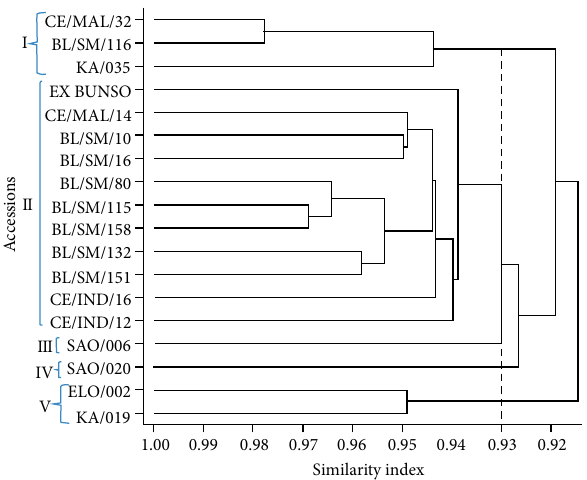
Figure 1: Cluster analysis based on biochemical